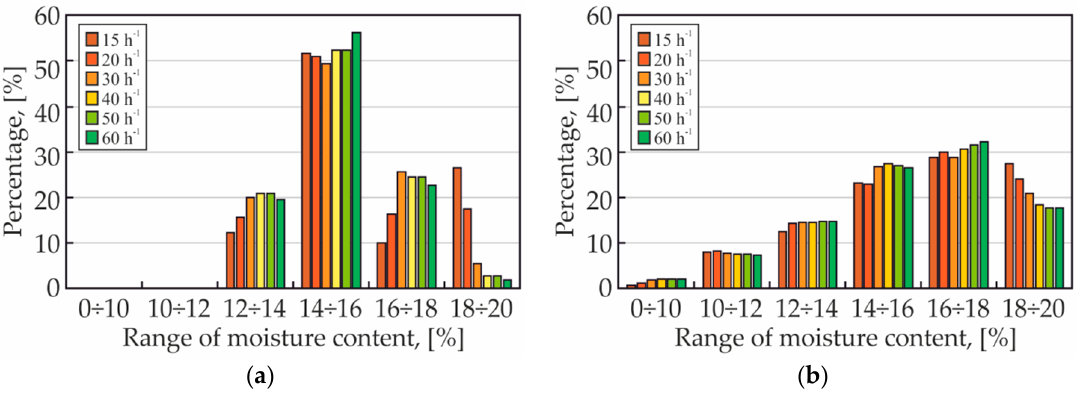
Figure 11. Annual share of moisture content range when increasing the ACH in ventilated rooftop layers for scenario A IV ( a ) and D IV ( b ) scenarios.